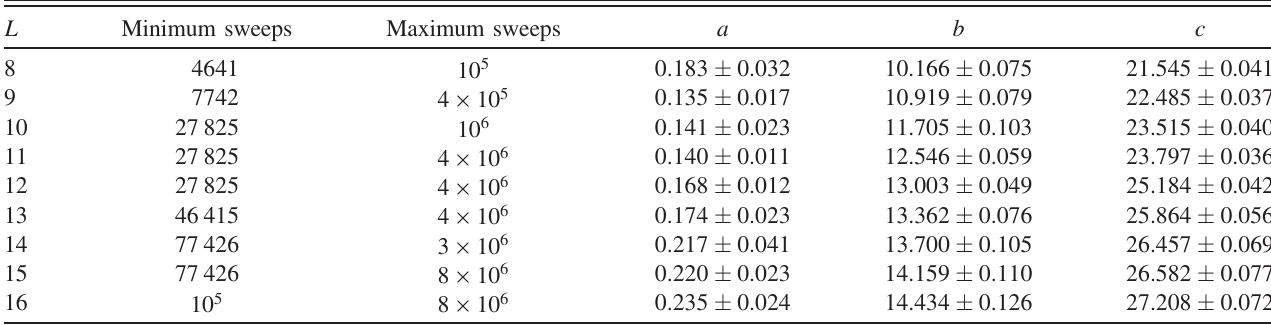
TABLE XV. Fit to y ¼ a ð x − b Þ 2 þ c for the median results of the logical-planted instances using the SVMC algorithm with y ¼ log TTS and x ¼ log n . The factor c does not include f sweeps